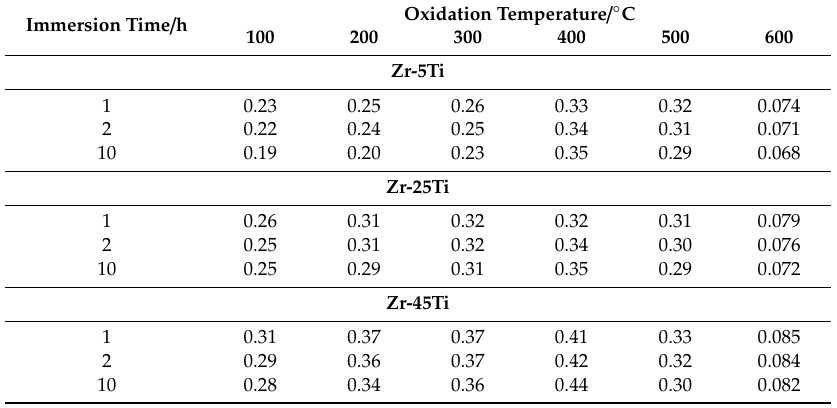
Table 5. Values of the polarization resistance (in M Ω · cm 2 ) as a function of immersion time of thermally oxidized Zr-Ti alloys in phosphate bu ff ered saline solution acidified at pH = 6.1 ±